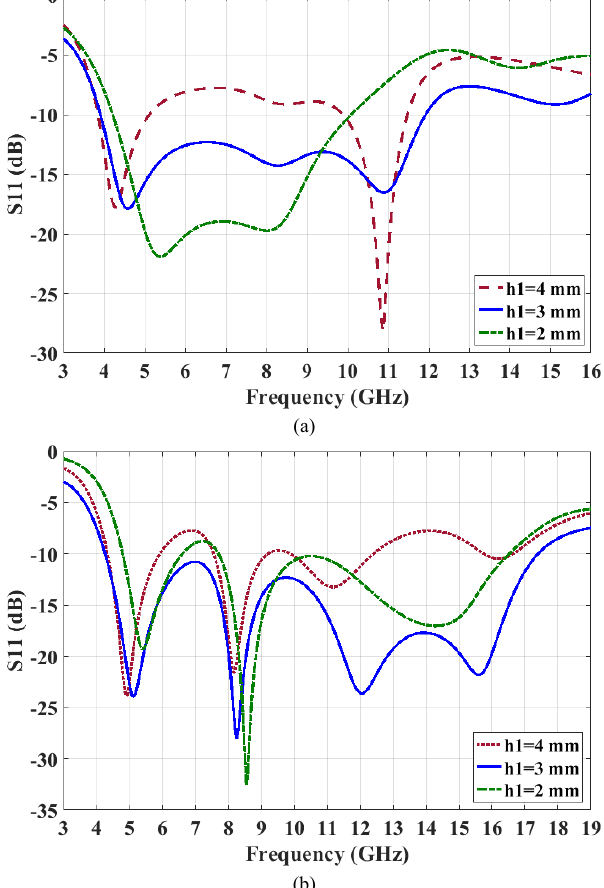
FIGURE 7 . S-parameters for various values of h 1 (a) full design (b) half